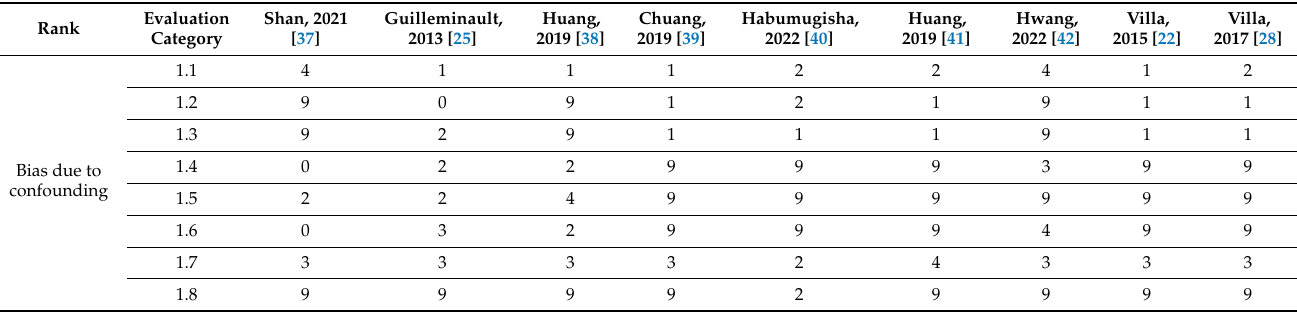
Table 4. Process for evaluating the ROBINS-I